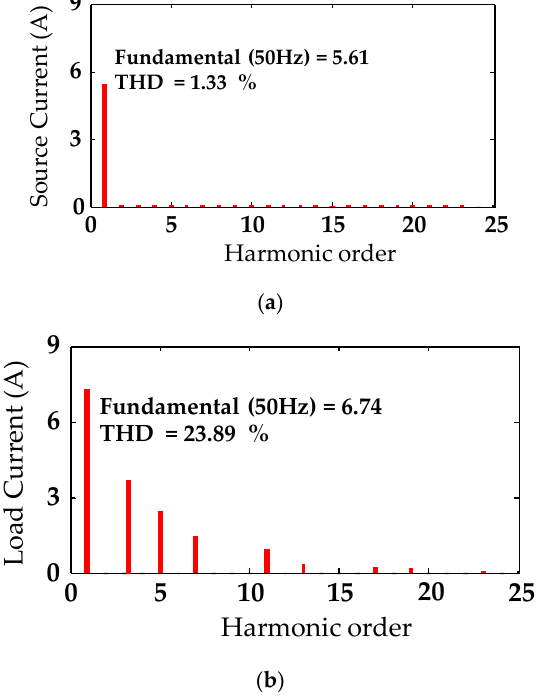
Figure 7. Current THD; ( a ) source current, ( b ) load current.